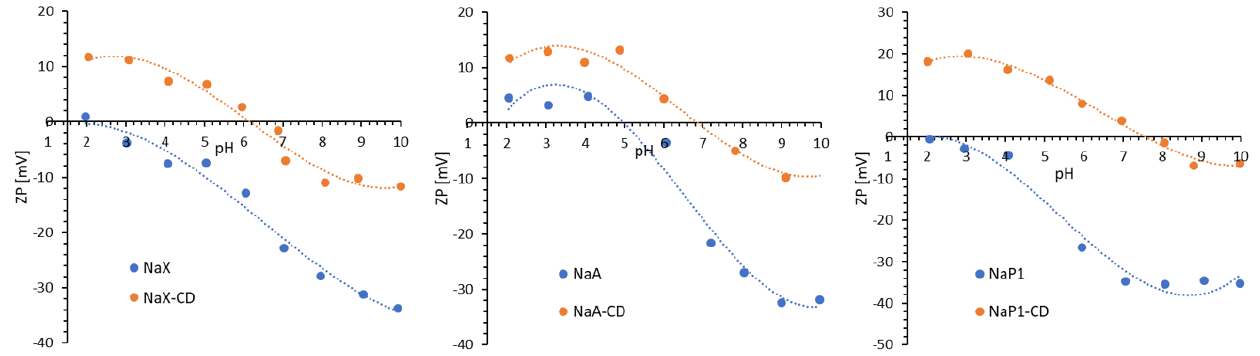
Figure 5. Zeta potential of zeolites NaX, NaA and NaP1 before and after modification with β